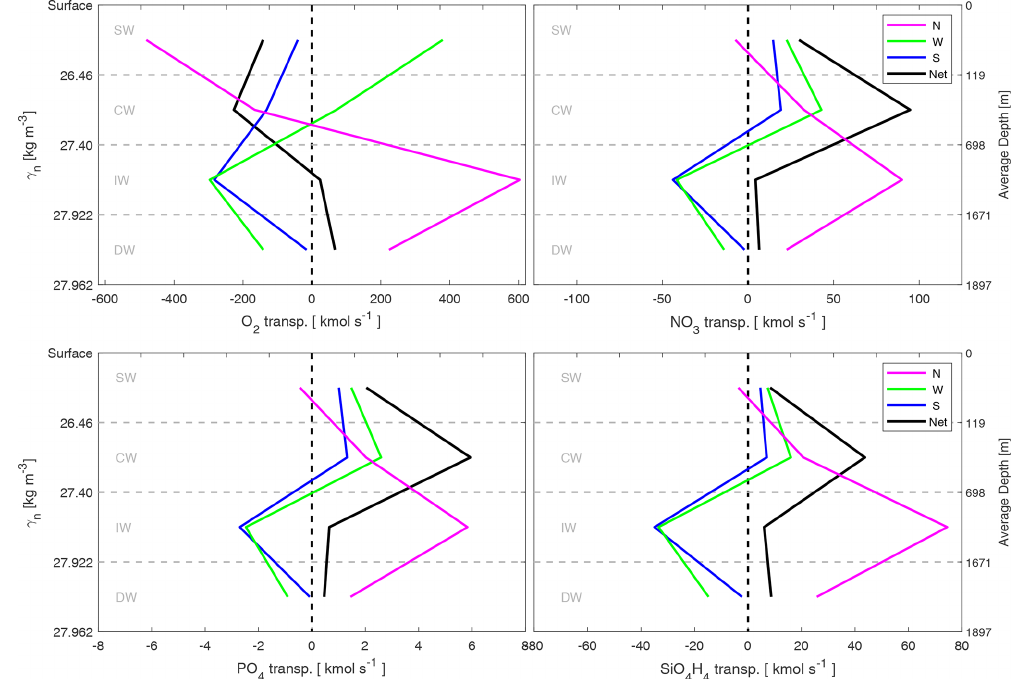
Figure 14. O 2 , NO 3 , PO 4 and SiO 4 H 4 transports (in kmols − 1 ) integrated per water-type level (SW, CW, IW and DW) in the north (N, pink line), west (W, green line) and south (S, blue line) transects during the FLUXES-I cruise (including WOA stations). The black line represents the net transport of each biochemical variable. See Table 2 to check the O 2 , NO 3 , PO 4 and SiO 4 H 4 transports’ values in each layer per transect. Negative (positive) values indicate inward (outward) transports, as in Fig.